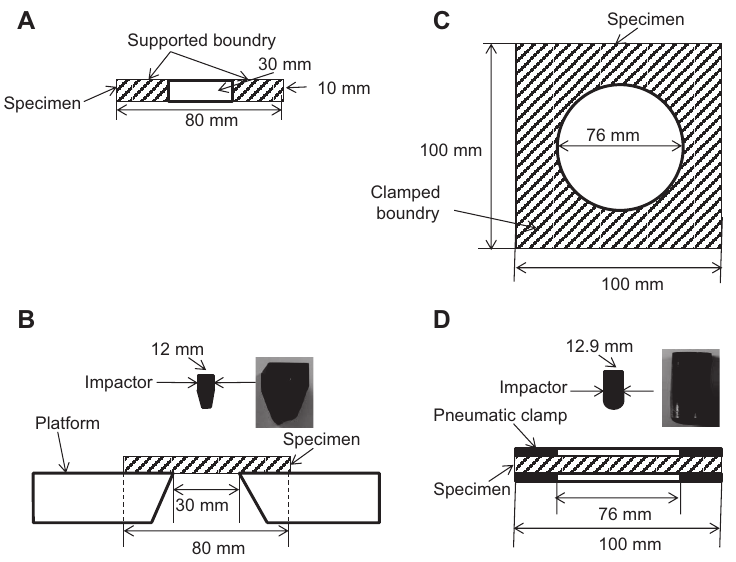
Figure 2 Schematic drawings of test set-ups: (A, B) three-point bending impact test and (C, D) plate bending impact test.